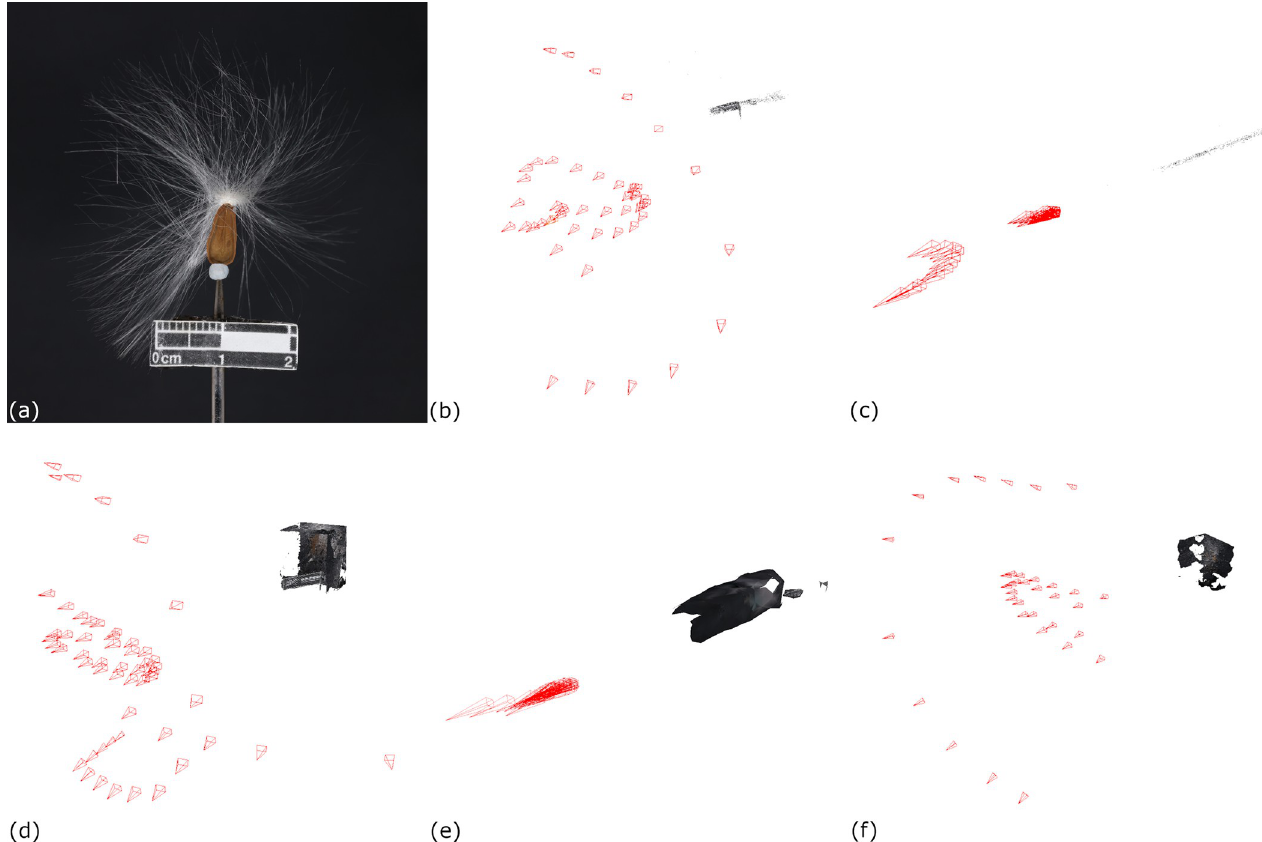
Fig 8. Reconstruction trials of carpological materials with filament-like and thin structures. (a) A Seed of Gymnema sylvestre (Retzius) Schultes with coma attached. (b)to(f) Results of the reconstruction trials of G . sylvestre showing the positions of the camera estimated by 3D Zephyr and the 3D models. https://doi.org/10.1371/journal.pone.0270199.g008 PLOS ONE | https://doi.org/10.1371/journal.pone.0270199 August 4,